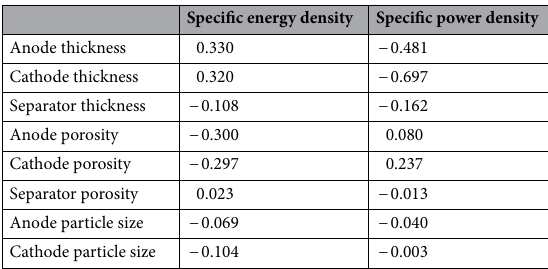
Table 3. Correlation coefficients of specific energy and specific power for design factors.